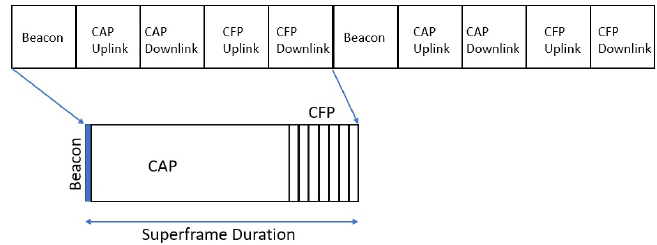
Figure 3. Frame structure—star